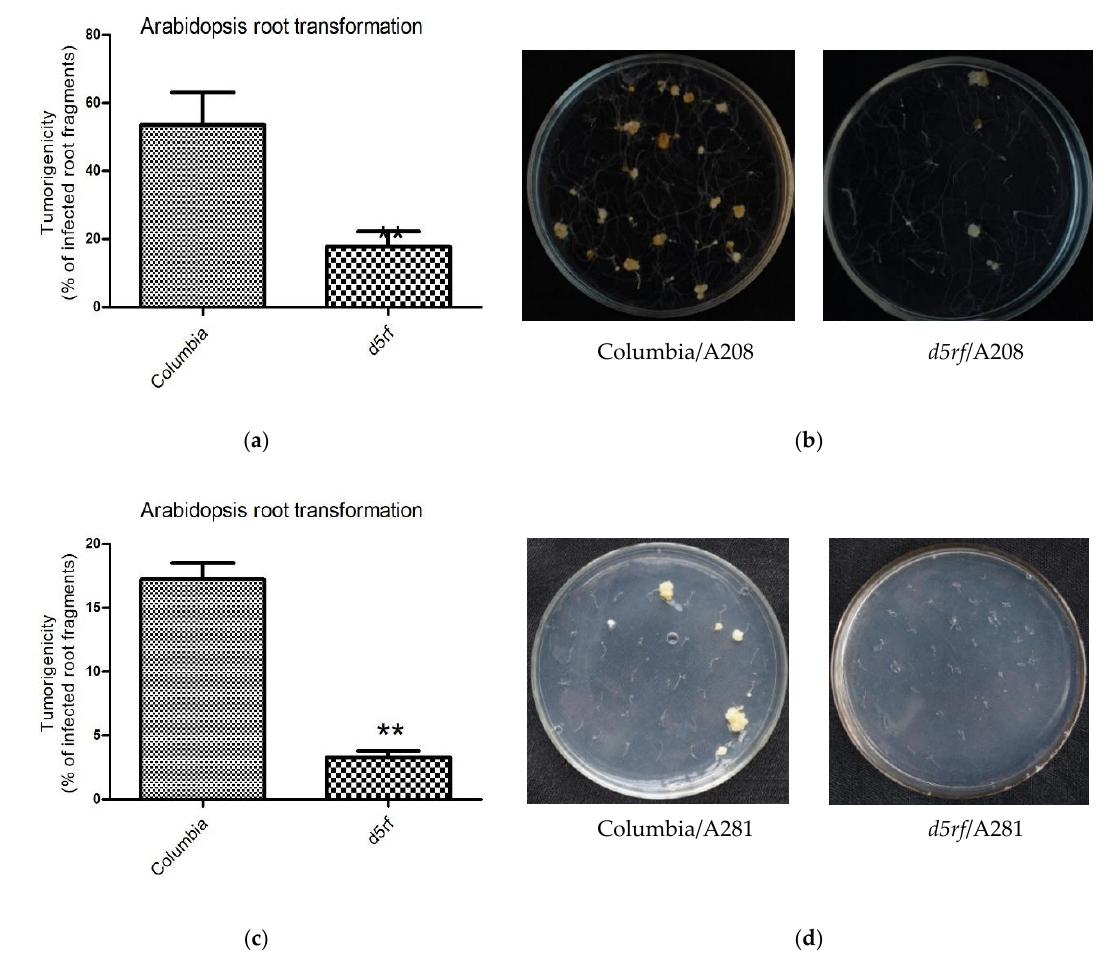
Figure 6. Stable transformation assays. Root segments of wild-type and d5rf mutant plants were infected with the tumorigenic strain A. tumefaciens A208 (nopaline strain), and tumors incited on the root segments were visualized and scored 3–4 weeks after infection ( a , b ). Root segments of wild-type and d5rf mutant plants were infected with the tumorigenic strain A. tumefaciens A281 (Succinamopine strain), and tumors incited on the roots were visualized and scored 30 d after infection ( c , d ). The stable transformation efficiency was calculated as: no. of root segments with tumor/no. of root segments infected. **, p < 0.01. Data are means SE from five ( a ) or three ( c ) biological replicates.